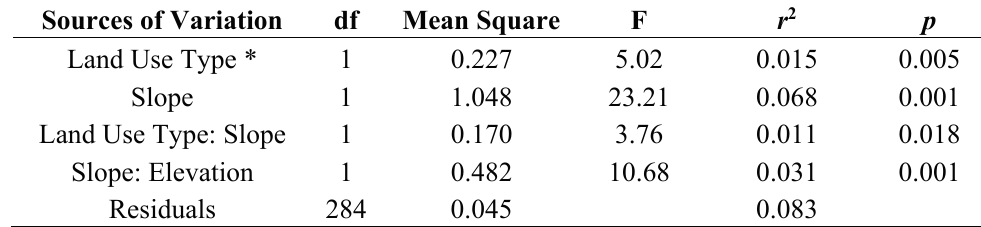
Table 2. Results from the PerMANOVA of the distance matrix constructed from the height bin LiDAR